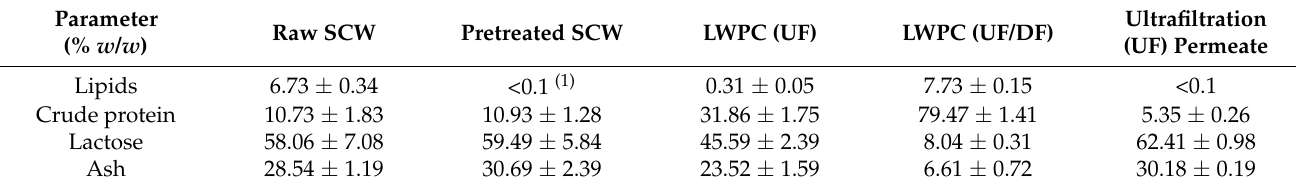
Table 1. Physicochemical characterization of samples of Second cheese whey from sheep (SCW) (dry basis). Parameter Raw SCW Pretreated SCW (% w / w ) Lipids